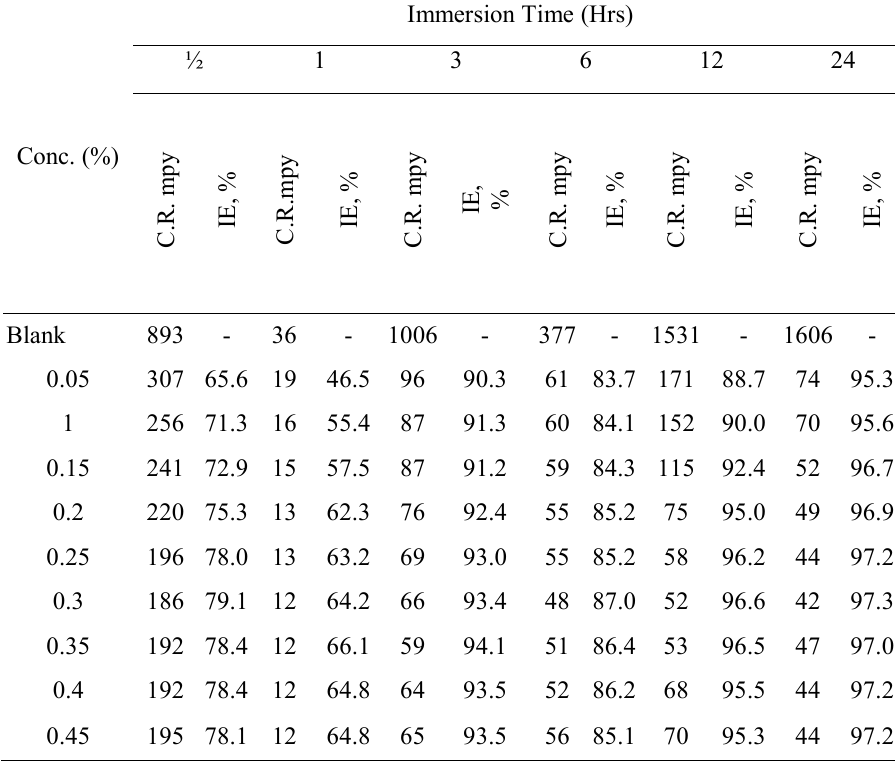
Table 1. Influence of concentration of SFCN extract and time on the corrosion rate of MS in 1M